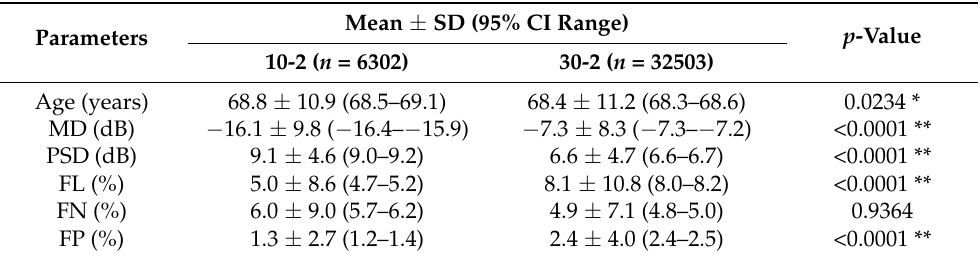
Table 7. Comparison of the parameters between the VF datasets of the central 10-2 and the 30-2 programs in subjects who are 40 years old or